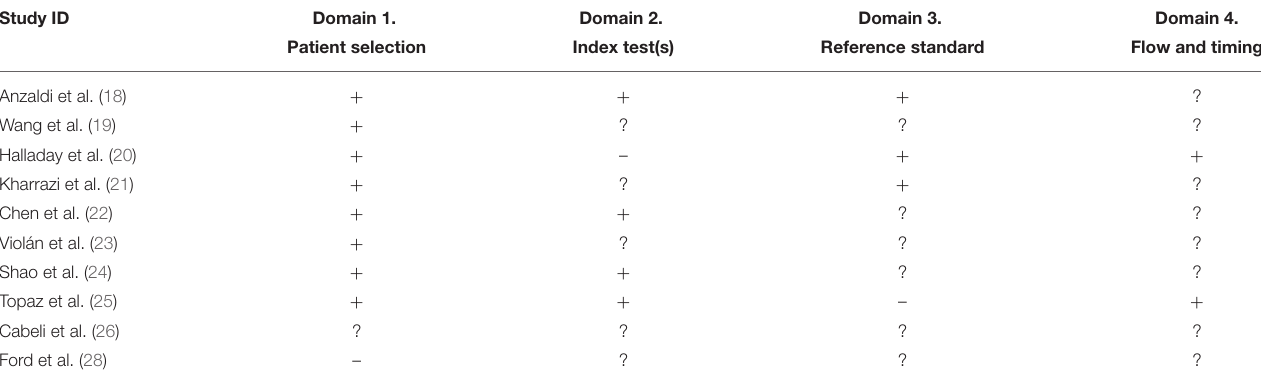
TABLE 3 | Study quality assessment using